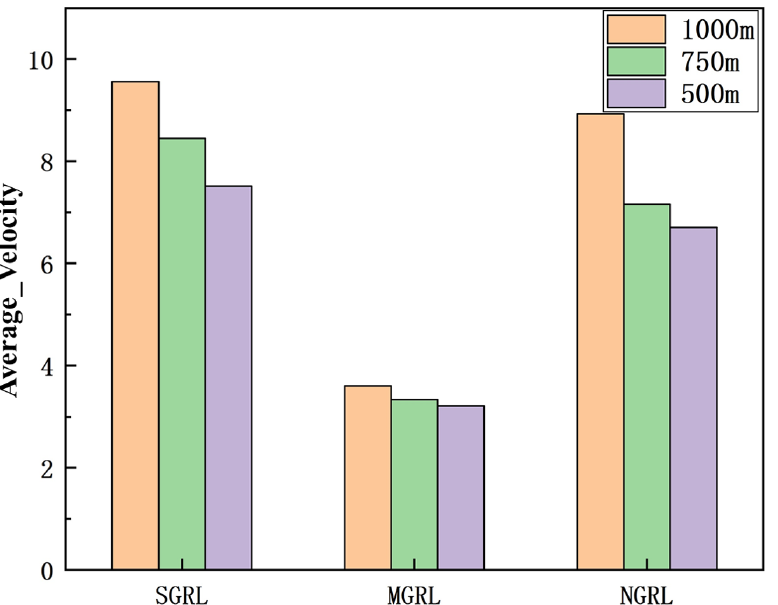
Figure 24. Diagram of testing average velocity. This value is the average velocity of all AVs in the